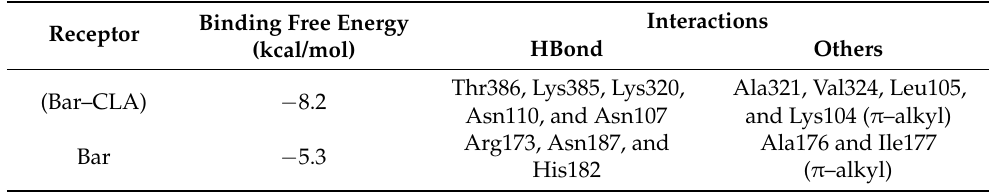
Table 3. The interaction data between (Bar–CLA) or Bar and serotonin (6BQH).